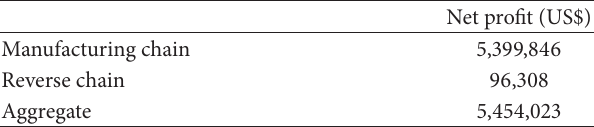
Table 6: Numerical